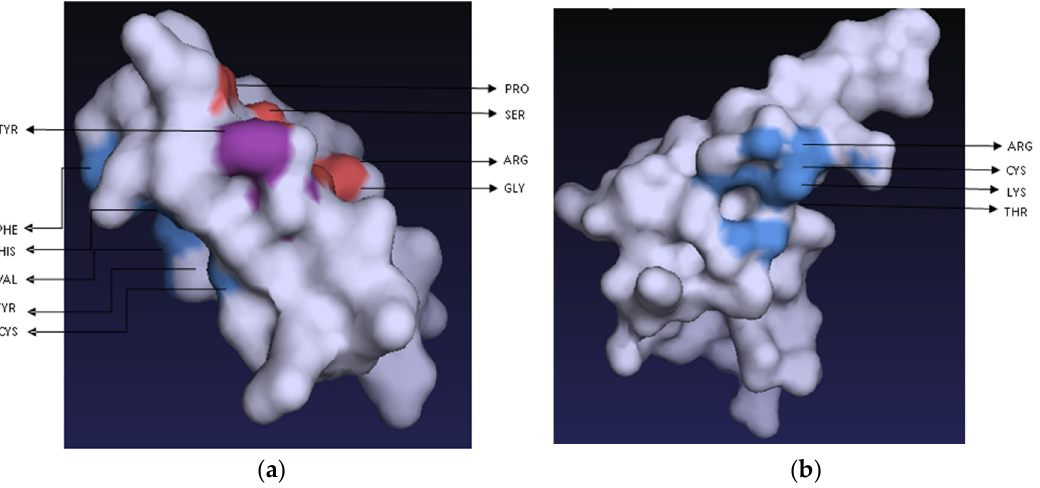
Figure 10. Binding-pocket sites and interacting residues on ( a ) actifensin and ( b ) defensin-d2 struc- tures predicted using PrankWeb.